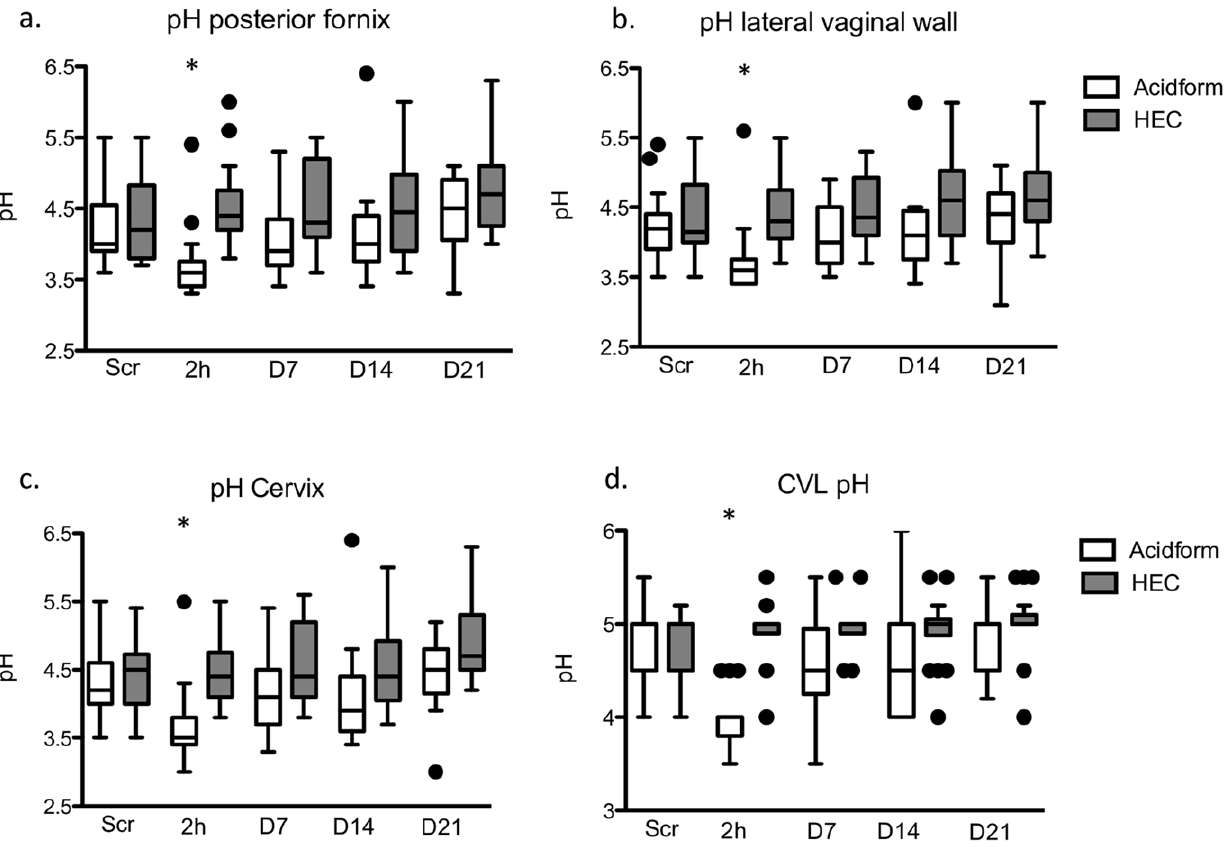
Figure 2. The pH of the vagina and cervix was significantly lower 2 hours after application of Acidform compared to HEC placebo gel. Box-and-whisker plots showing the pH of the posterior fornix (a), lateral vaginal wall (b), cervix (c) and CVL (d) obtained at screening (Scr), 2 hours (2 h) and at Days 7, 14 and 21 after insertion of Acidform (white) or HEC placebo gel (gray). The line indicates the median values and the circles are outliers. The asterisks denote a significant difference between the Acidform and HEC placebo